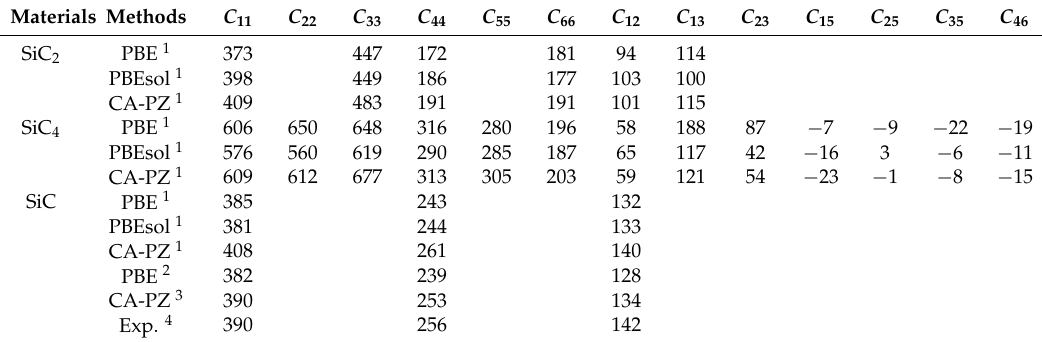
Table 2. The calculated elastic constants of SiC 2 , SiC 4 , and